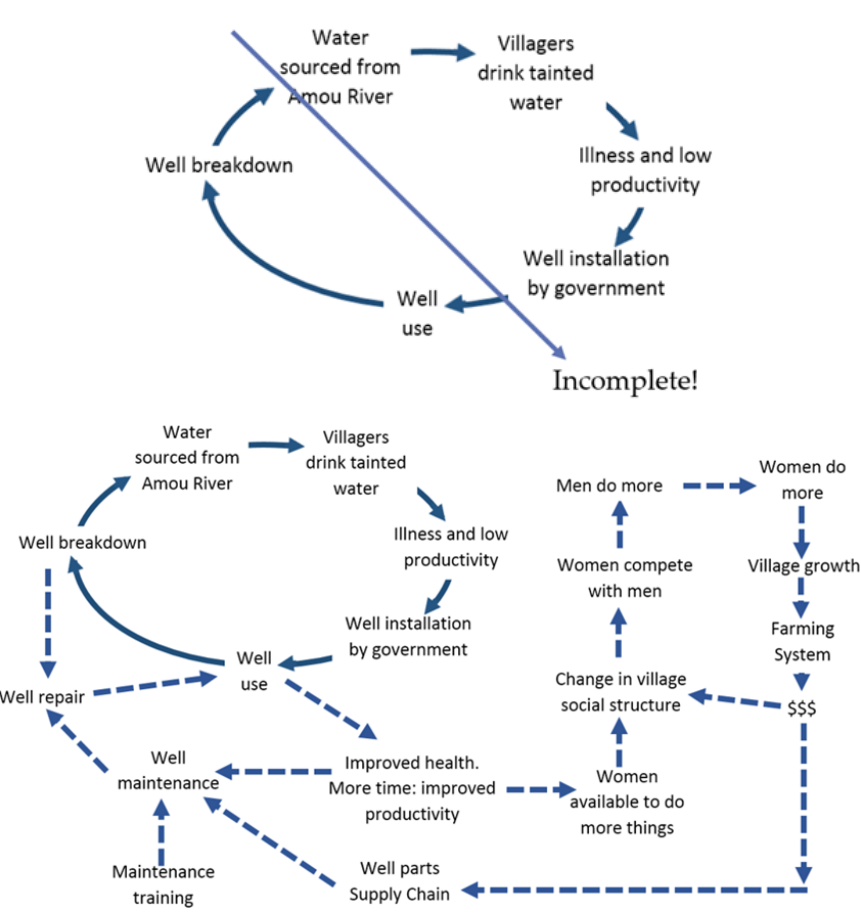
Fig. 32. Initial (upper) and final (lower) causal loop diagrams for the water of